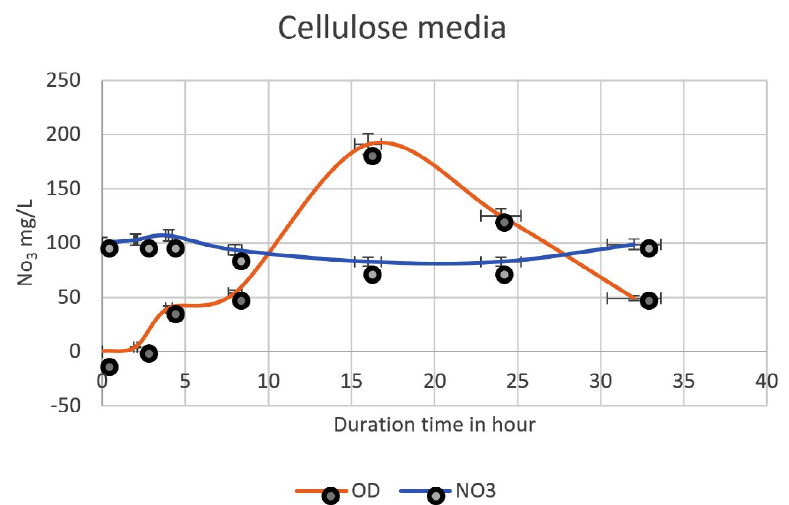
Fig. 2. The nitrate was denitrified by Pseudomonas aeruginosa on mineral media with cellulose. The highest denitrification level of nitrate was achieved after 16h (64 mg/L) off 100mg/L.